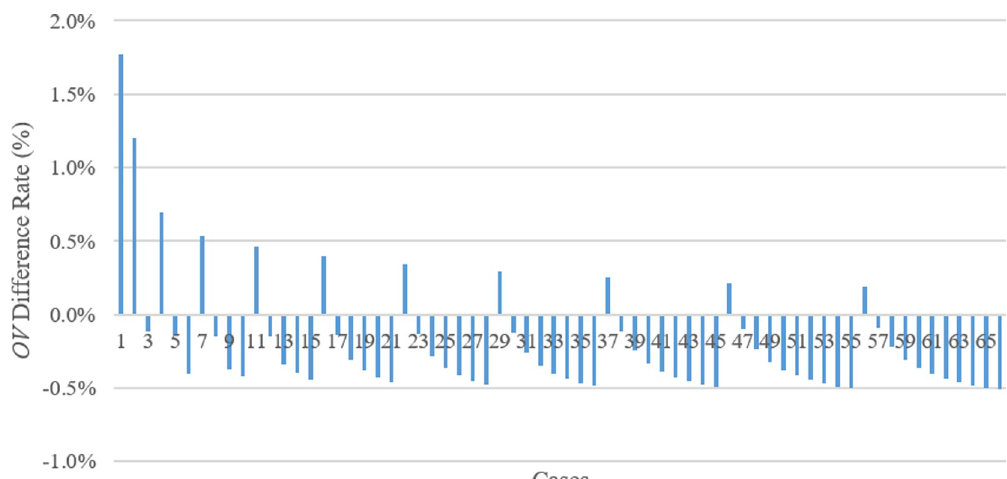
Fig 15. Comparison between TSA and WOA in terms of OV difference rate.